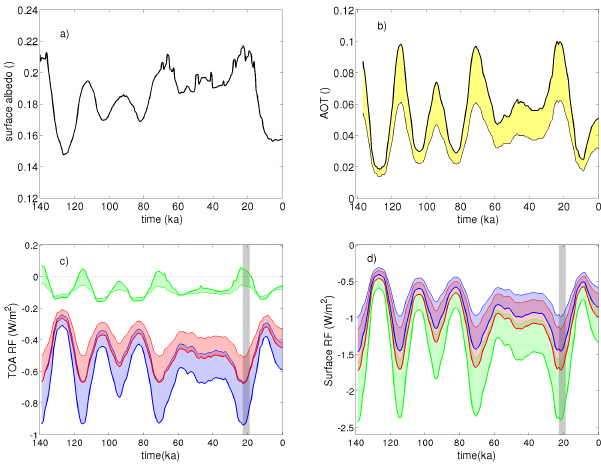
Fig. 5. Time series of annual global mean surface albedo (a) , dust AOT (b) and dust SW DRF (W m − 2 ) Figure 5. Time series of annual global mean surface albedo (a) , dust at TOA (c) and at surface (d) for last 140 kyr . b) Range of dust AOT (yellow shaded) from solutions AOT (b) and dust SW DRF (W m − 2 ) at TOA (c) and at surface (d) L1 (thick line) and L2 (thin line), respectively. c) and d) DRF from six simulation experiments using for last 140kyr. (b) Range of dust AOT (yellow shaded) from so- dust AOT from L1 and L2 (line width as in b) ) and RI =0 . 0005 (blue shaded), 0 . 0015 (red shaded) and 0 . 0060 (green shaded). Gray-shaded bars as in Fig. 1. lutions L1 (thick line) and L2 (thin line), respectively. (c) and (d) DRF from six simulation experiments using dust AOT from L1 and L2 (line width as in (b) and RI = 0 . 0005 (blue shaded), 0 . 0015 (red 40 shaded) and 0 . 0060 (green shaded). Vertical grey bars as in Fig.